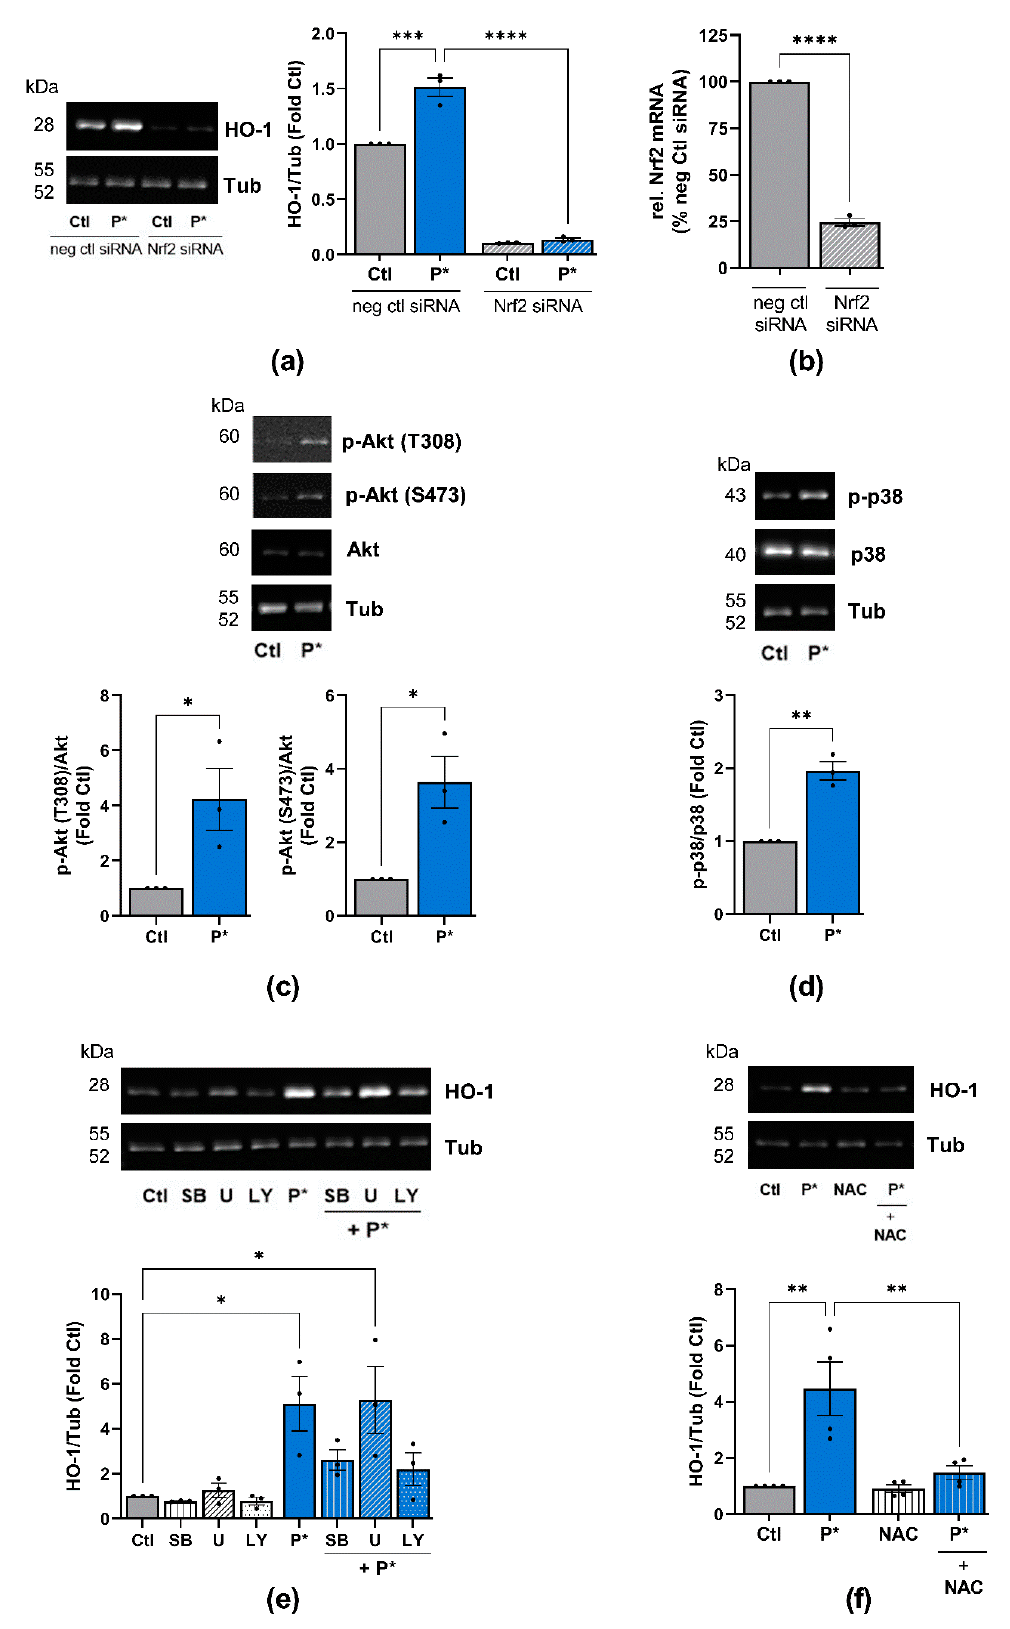
Figure 5. P*-mediated HO-1 induction requires activation of Nrf2, PI3K/Akt, and p38 MAPK pathways. ( a ) ATDC5 cells transfected with Nrf2 (Nrf2 siRNA) or negative control (neg ctl siRNA) siRNA were preincubated with 0.5 mM P* for 6 h. Expression of HO-1 was analyzed by Western blotting using α , β -tubulin (Tub) as control. Representative Western blots are shown. Densitometry analysis values of HO-1 were normalized against Tub and expressed as relative quantity com- pared to untreated cells (Ctl) set to 1, n = 3, *** p < 0.001, **** p < 0.0001. ( b ) Knockdown efficiency of Nrf2 by siRNA was